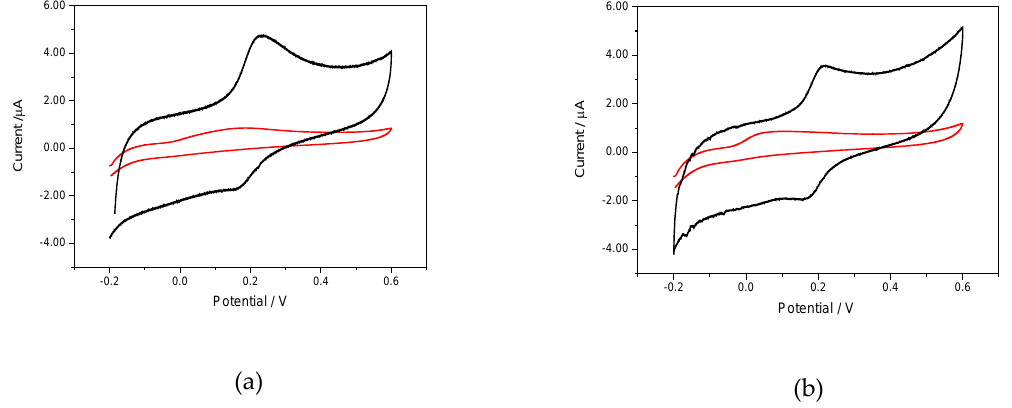
Figure 5. Voltammetric response of preloaded ( a ) PAAm and ( b ) NanoC with DA (back line) and AA (red line) from respective solution 0.25 mM in PBS pH 7. Scan rate: 10 mV/s. The electrochemical response of PAAm and NanoC LSV was carried out using the preloaded matrices with a solution of 1 mM DA and 1 mM AA in PBS (pH 7), at scan rate of 1 mV/s (Figure 6).